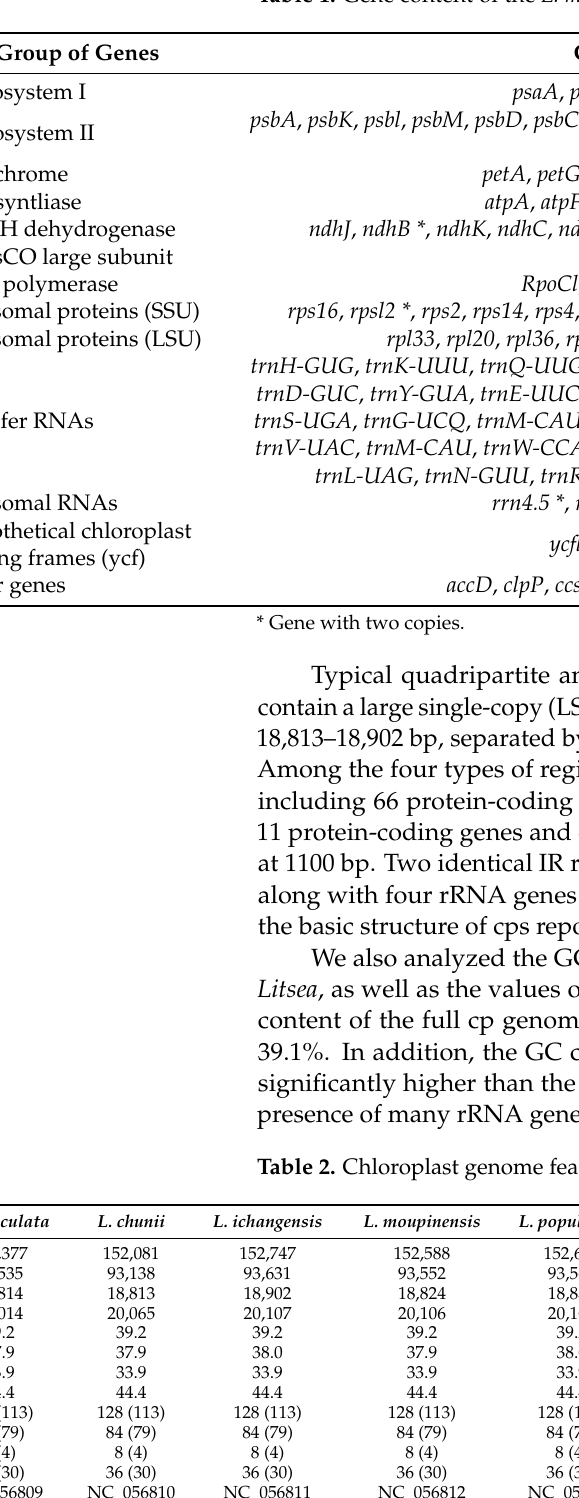
Table 1. Gene content of the L. moupinensis chloroplast genome.